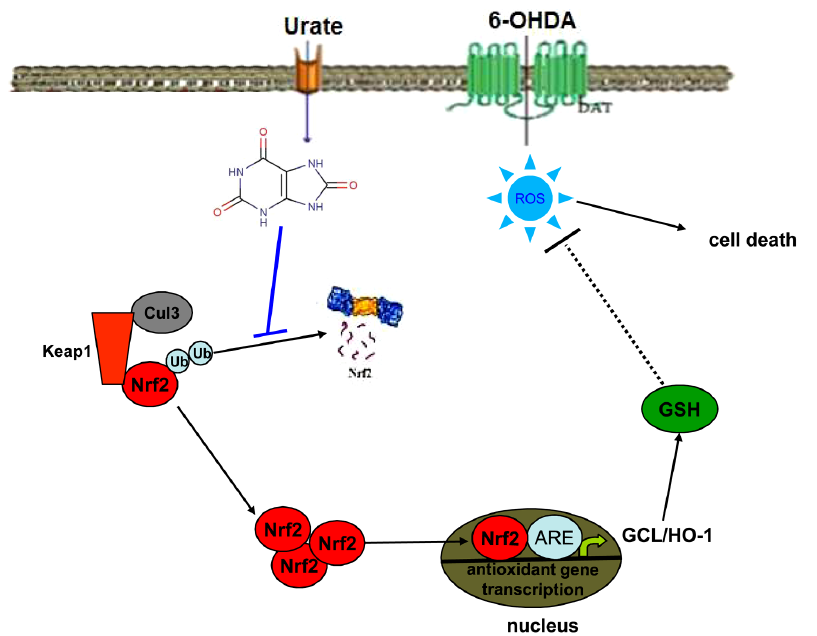
Figure 8. Schematic representations illustrating how urate may activate Nrf2 and thus protects against oxidative stresses. Urate may be accumulated into cells via undefined transporters. It led to Nrf2 accumulation by inhibiting its ubiquitination and degradation and promoted Nrf2 translocate into nuclei, where Nrf2 may transactivate the transcription of antioxidant enzyme genes such as GCL, HO-1, and thus protected against oxidative stresses in dopaminergic cells.